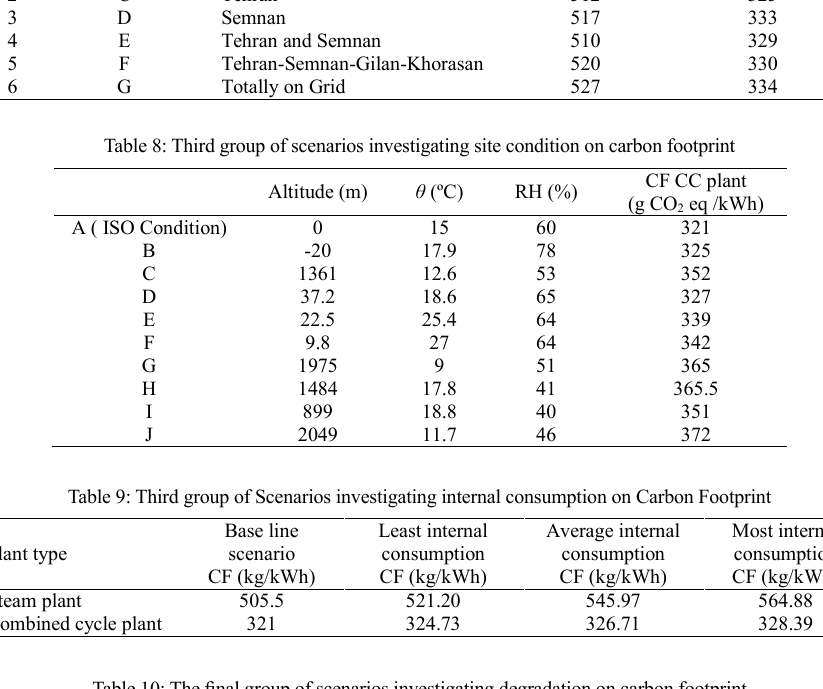
Table 7: Second group of scenarios investigating transmission and distribution losses on carbon footprint No.